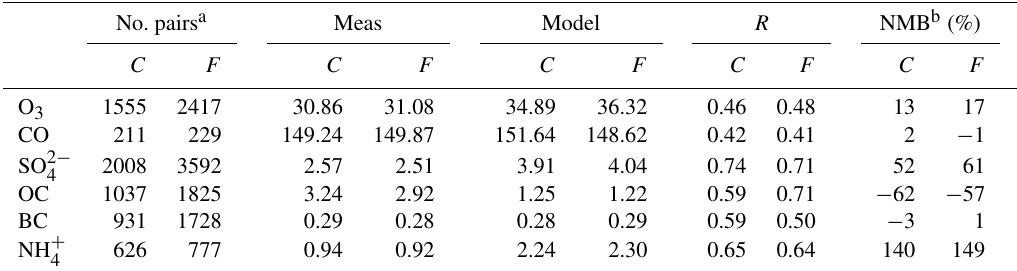
a The number of pairs corresponds to the number of grid boxes that contain measurements. Hence the larger number of pairs in the finer